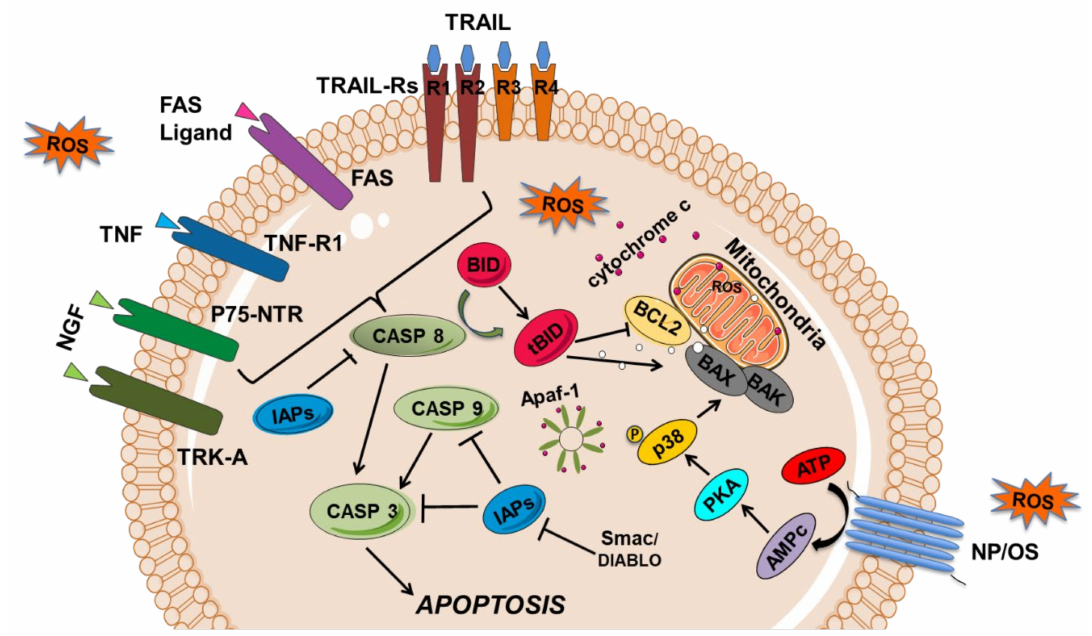
Figure 2. Representation of cell signaling pathways leading to apoptosis. Apoptosis can result from the activation of the extrinsic and intrinsic apoptosis pathways. The extrinsic or membrane pathway starts by the interaction of a death ligand from the TNF (tumor necrosis factor) family, TNF, FAS-L, TRAIL (TNF related apoptotic inducing ligand), and NGF (nerve growth factor) to the respective receptors, TNF-R1, FAS, TRAIL-R1-R2, and p75-NTR, which subsequently activate a caspase cascade (caspase 8 and 3). In mitochondria-mediated apoptosis or intrinsic pathway, proteins of BCL-2 family (BAX, BAK; BCL2) and cytochrome c are released, binding to the apoptotic protease-activating factor-1 (APAF-1) and caspase 9 (CASP 9) forms a complex called the apoptosome, which is capable of recruiting caspase-9, -3 (CASP3) and -7, and inducing apoptosis. Several apoptotic regulators are also represented, such as the CASP inhibitors (namely the IAPs—inhibitor of apoptosis proteins) and the IAPS inhibitors SMAC/DIABLO (second mitochondria-derived activator of caspase/direct inhibitor of apoptosis-binding protein with low pI). In neuropathic pain (NP), oxidative stress (OS)/ROS generated exogenously or endogenously can activate p53, which activates the proapoptotic BCL-2 proteins that can inhibit the functions of the antiapoptotic proteins, such as BAX and BAK. Besides, OS can induce nerve apoptosis by activating BAX through protein kinase A (PKA) and p38 pathway. Transmembrane death receptors such as FAS, TRAIL-R1/2, and TNF-R1 can also be activated by